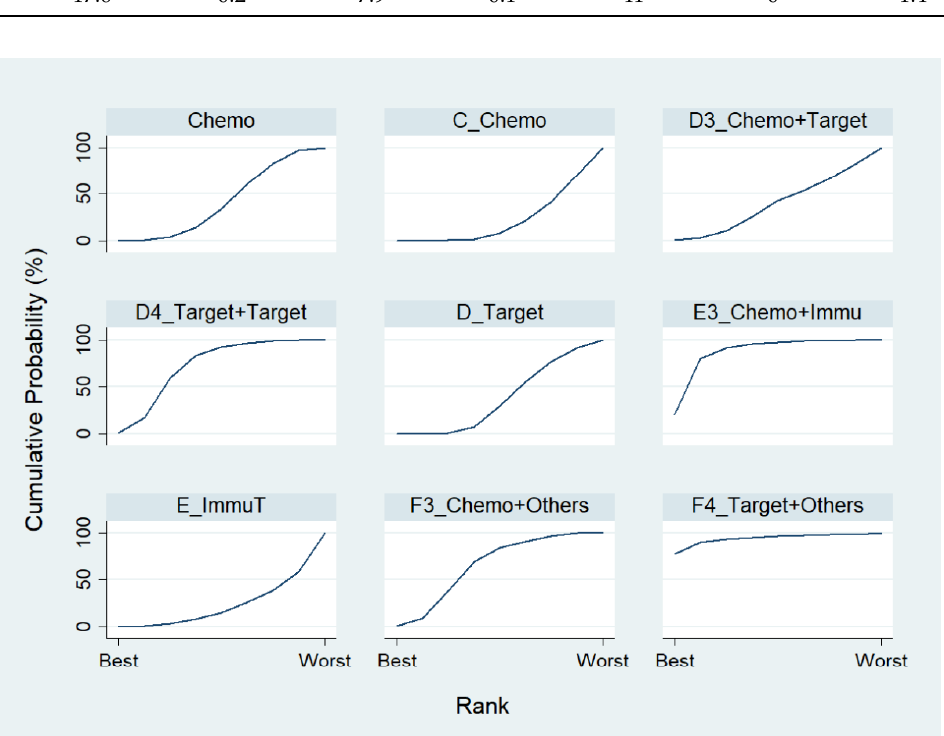
Figure 7. Rankogram for advanced lung cancer in disease-free control rate.